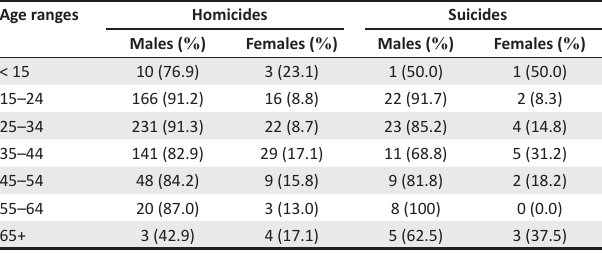
TABLE 10: Homicide and suicide by gender and age (preliminary NMSS data, first quarter